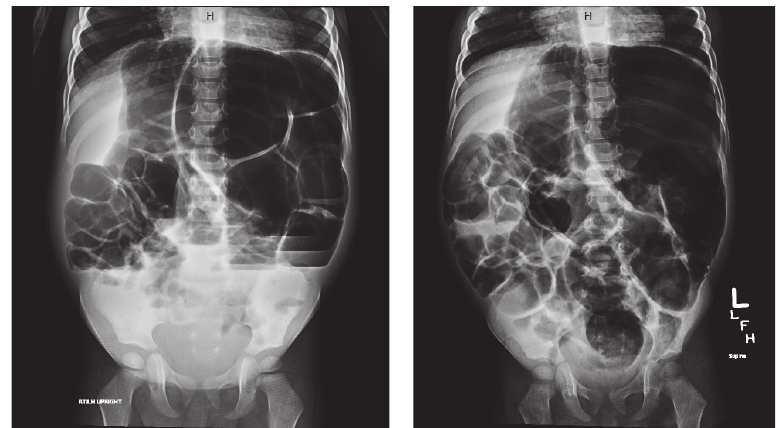
Figure 3: Supine and upright plain X-rays of the patient presented in Case 2. The stomach is markedly distended and filled with air. There is moderate and severe distention of several bowel loops, with air-fluid